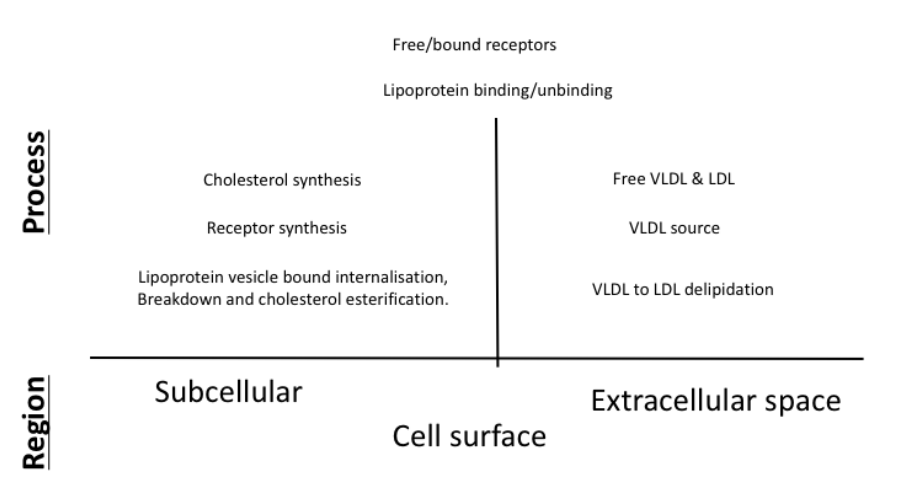
Figure 1. An overview of the main features included in our integrated mathematical model of cholesterol and receptor biosynthesis coupled with lipoprotein (VLDL and LDL)